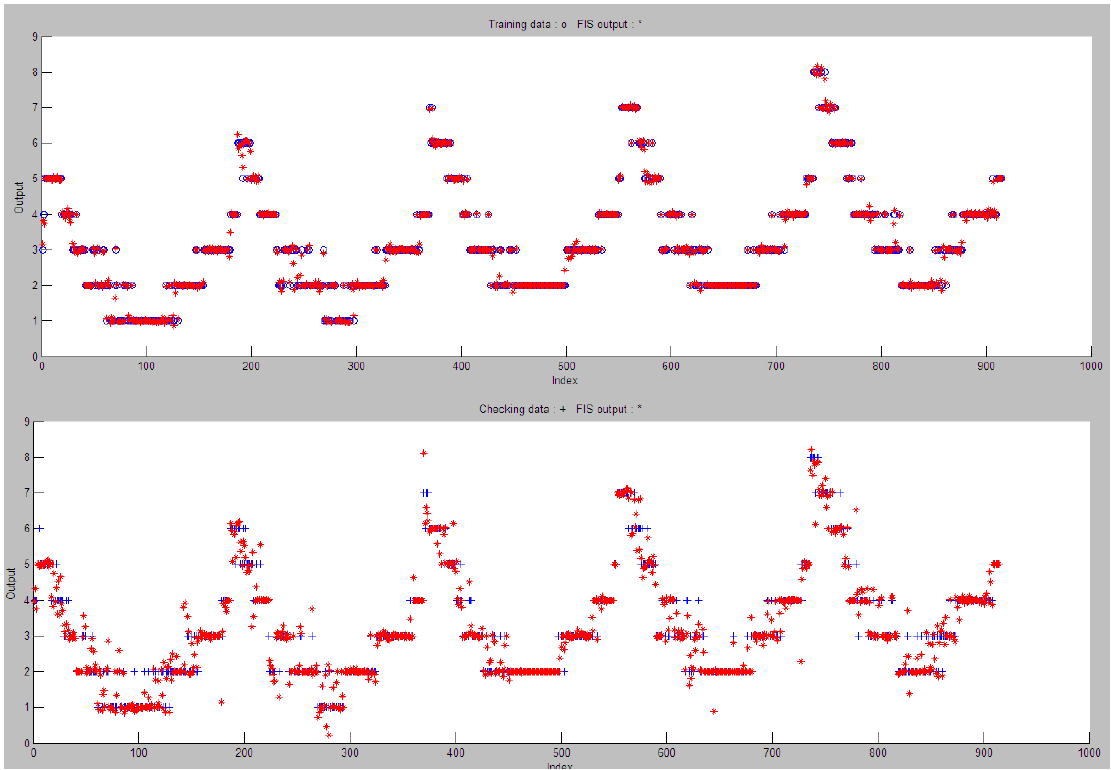
Figure 18. Evaluation of the ANFIS for the training (up) and testing (down)